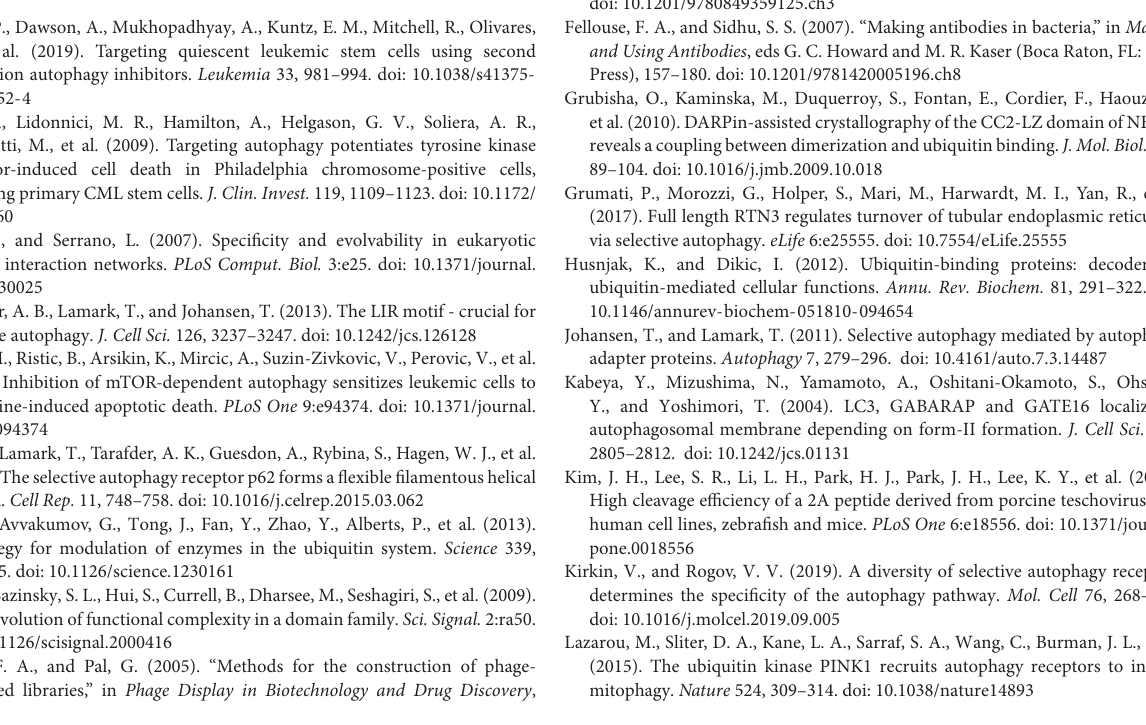
indicated concentrations of GST-p62 and probed on immobilized GST-p62. Results are shown as normalized OD450 to the signal in the absence of competitor. FIGURE S2 | Annexin A4-based membrane co-translocation assay in HeLa cells. Micrographs before (upper row) and after addition of 10 µ M ionomycin (lower row) are shown. (A) Assay results for LC3Bwt and OPTN. (B) Results for GATE-16wt and p62. (C) Cross-specificity test for binding of p62.GATE-16v to OPTN (left panel) and of OPTN.LC3Bv to p62. Scale bars represent 20 µ m. FIGURE S3 | Gene-ontology analysis of proteins detected in Co-IP MS/MS experiment using SGFP2-NDP52.LC3Bv. Proteins with an enrichment factor of log 2 > 2 relative to LC3Bwt were analyzed using Panther14.1. From 210 proteins submitted, a GO-term enrichment for 127 proteins for the indicated protein function was detected. FIGURE S4 | qPCR analysis of the mRNA transcription of 3xWT or 3xInh constructs. The T2A linked expression cassettes for SGFP2-3xInh or mCherry-3xWT constructs were analyzed using individual primer pairs for each LC3/GABARAP wt or variant construct and GAPDH control. Average amplicon length was 138 bp. The C(t) values of four independent amplification experiments are represented as box plot for each expression cassette in absence (black) or presence of doxycycline (magenta). Error bars correspond to standard deviation of four independent replicates. P -values were calculated using an unpaired Students TABLE S1 | Complete datasets from co-immunoprecipitation and mass spectrometry used to generate Christmas tree plots in Figures 4D–F . Enrichment of OPTN.LC3Bv vs LC3Bwt detected peptides. Enrichment of NDP52.LC3Bv vs LC3Bwt detected peptides. Enrichment of p62.GATE-16v vs GATE-16wt detected peptides. TABLE S2 | List of 24 known LIR containing proteins that have been shown to interact with LC3/GABARAP family (Wild et al.,